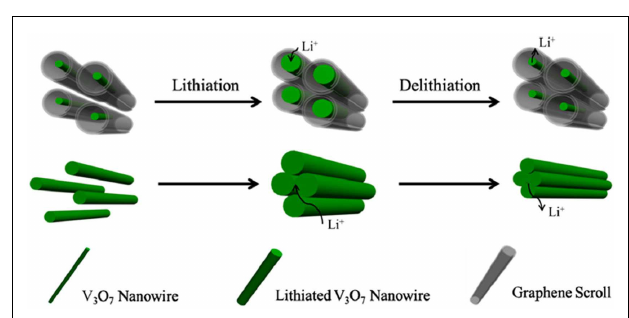
FIGURE 4 | Schematic of theVGS nanoarchitecture with continuous electron and Li-ion transfer channels . Reprinted with permission from Yan et al. (2013). Copyright 2013 American Chemical